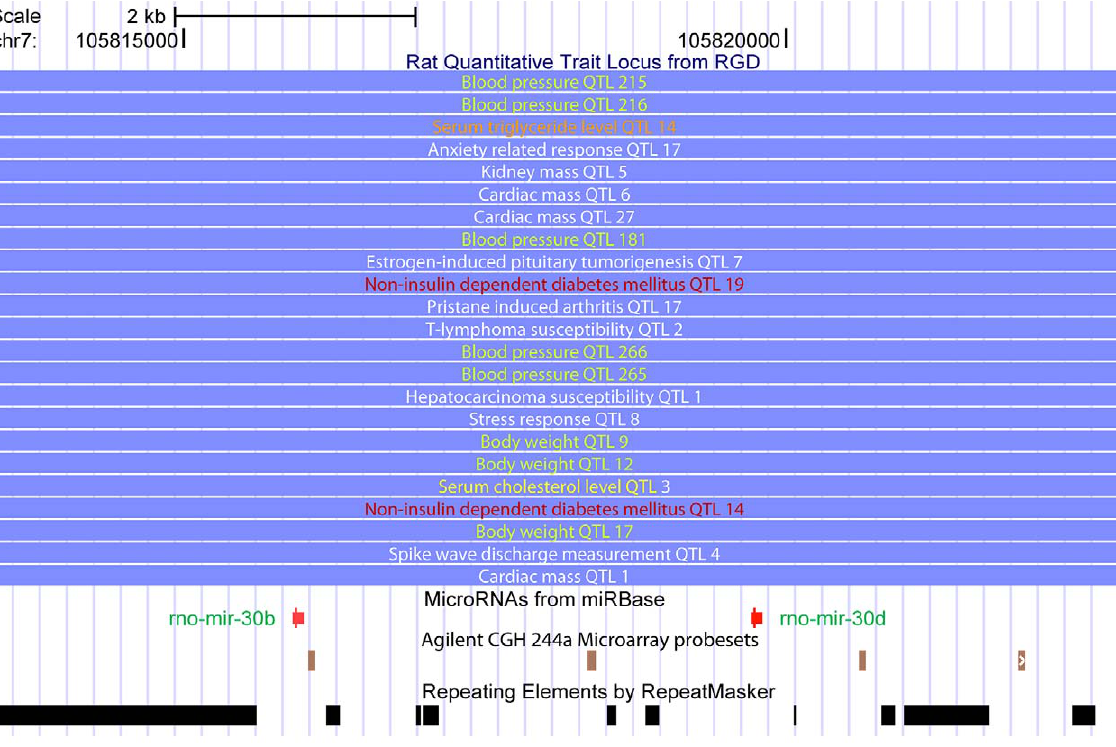
Figure 2. The microRNA rno-mir-30b and rno-mir-30d located in T2D QTLs. The QTLs of Niddm (Non-insulin dependent diabetes mellitus) 14 and 19 cover these 2 microRNAs. In addition, there are many other QTLs like ‘‘serum triglyceride 14’’, ‘‘serum cholesterol 3’’, ‘‘blood pressure 181/215/ 216/265/266’’, ‘‘body weight 9/12/17’’ in this region, and these traits are known to be related to diabetes. This figure was prepared using UCSC genome browser.